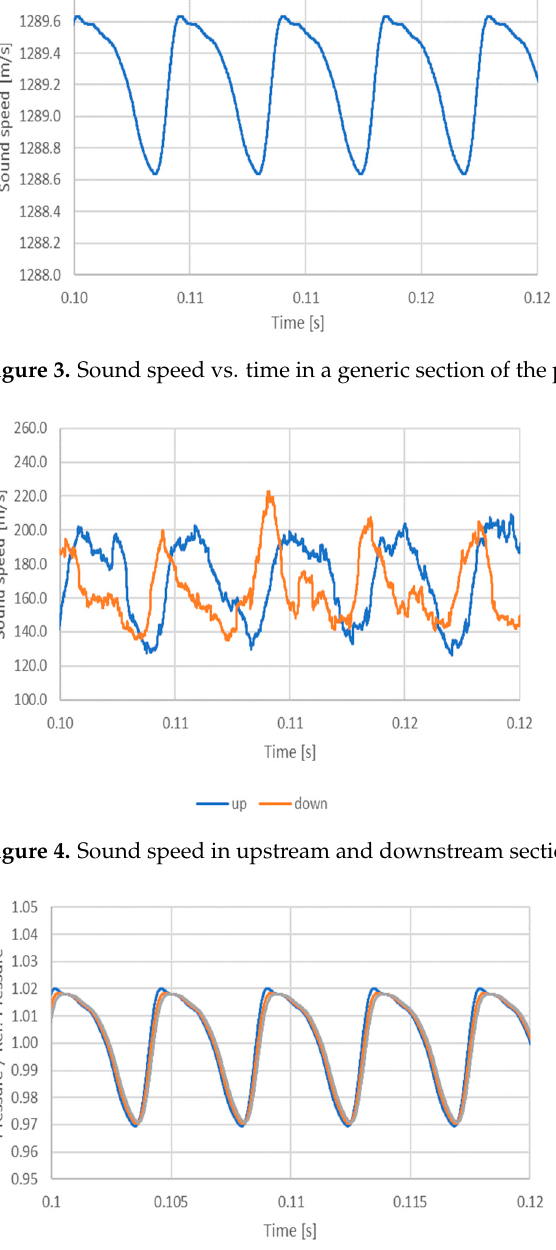
Figure 6. Pressure evolution in di ff erent damper sections, pump speed = 1500 rpm. In the following graphs, a comparison between numerical and experimental data is reported. The graphs report the FFT analysis of the pressure ripple, both numerical and experimental. These graphs also report the case without a damper in order to present an easy eval- uation of its performance. In Figures 7–18, the legend “Exp. No sup.” represents the test carried out without the damper, while “Numerical No sup.” represents the numerical re- sults with the damper inactivated.